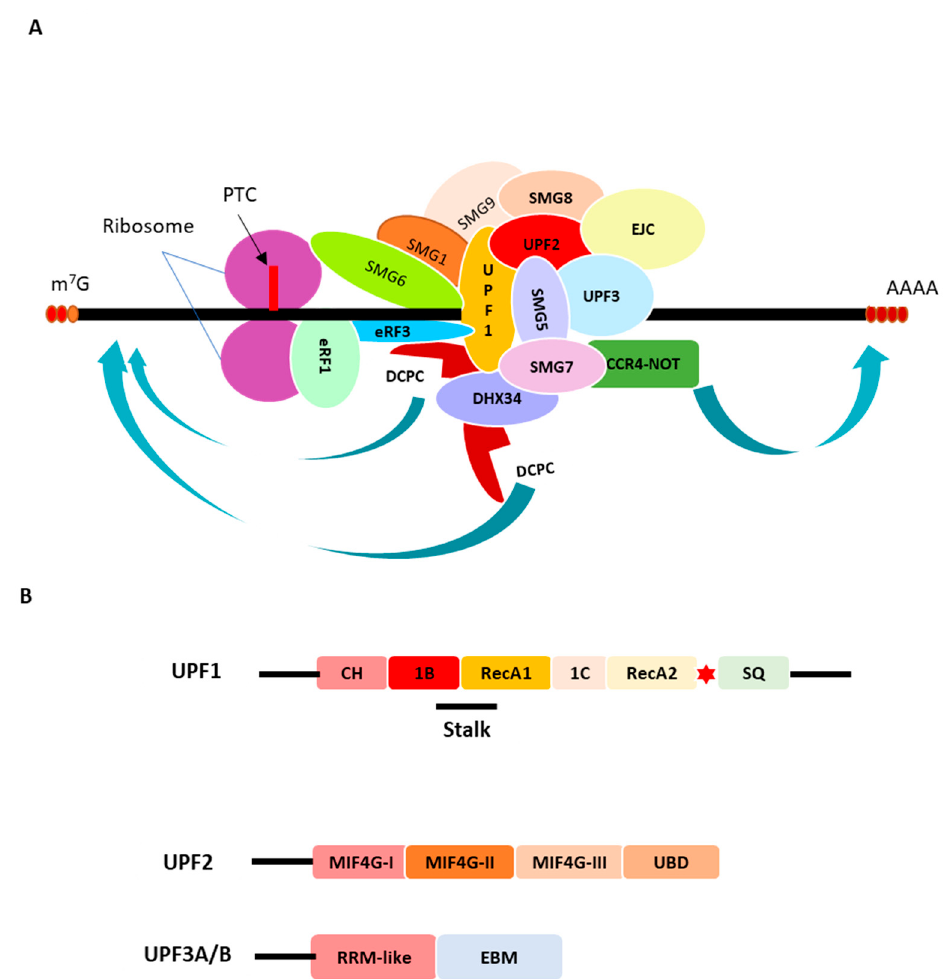
Figure 1. Schematic representation of the NMD factors. ( A ) The NMD reaction of the NMD factors. UPF: up-frameshift; SMG: suppressor of morphogenetic effect on genitalia; DHX34: DEAH box polypeptide 34; DCPC: decapping complex; EJC: exon junction complex; CCR4-NOT: carbon catabolite repressor protein 4 (CCR4)-NOT deadenylase complex. ( B ) The UPF protein construction. CH: cysteine–histidine-rich domain; 1B and 1C: subdomains within the helicase core; Stalk: RecA1 domains by two long “stalk” helices; RecA1 and RecA2: RecA-like domains; 1B and 1C: subdomains within the helicase core; SQ: serine–glutamine-rich domain; RRM: RNA recognition motif; EBM: exon junction motif; MIF4G: middle of 4G-like domains; UBD: UPF1-binding domain.